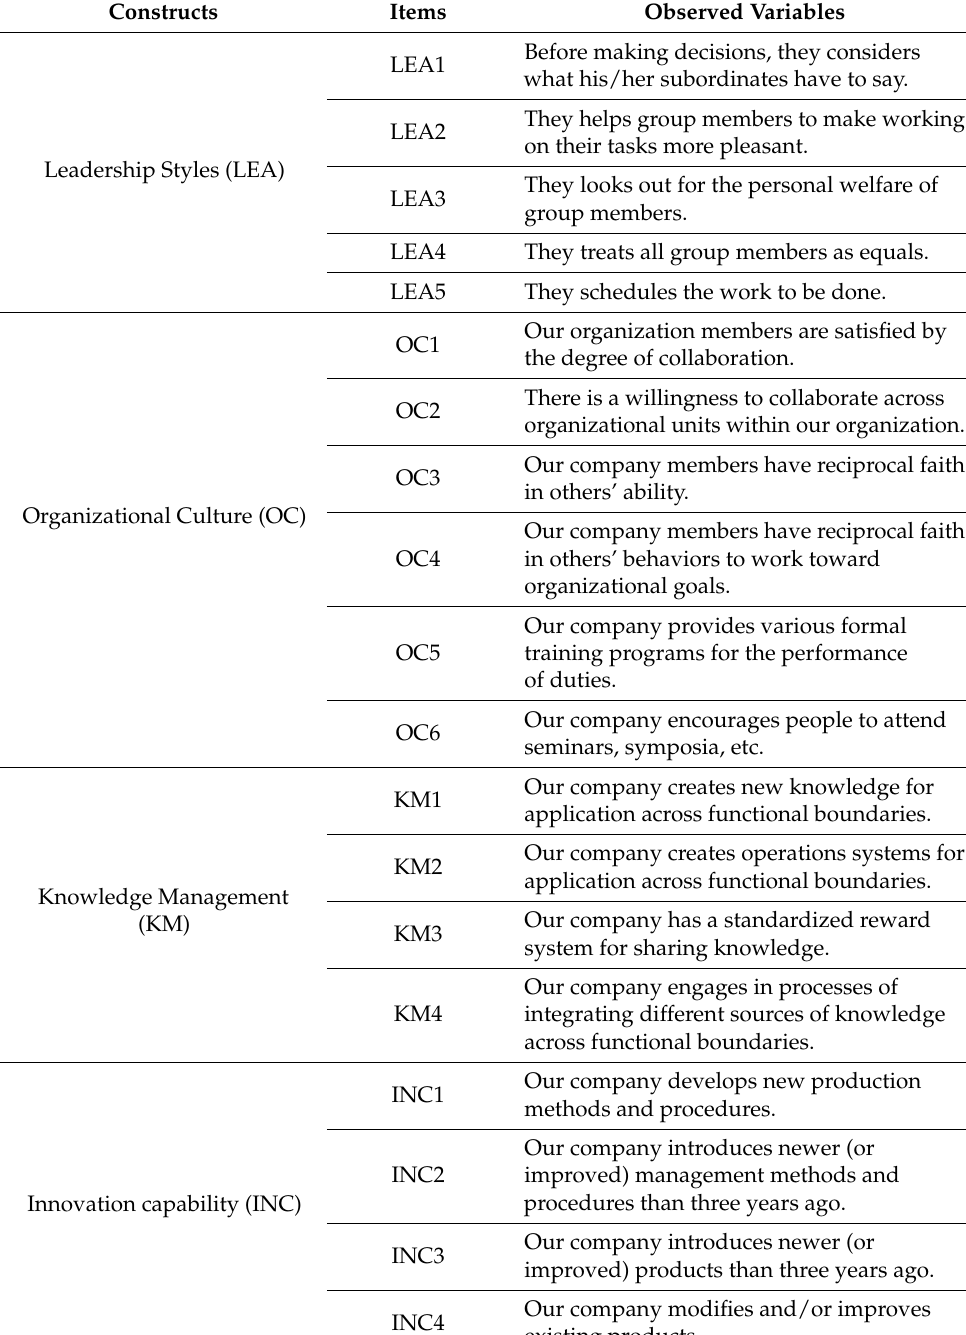
Table 2. Questionnaire constructs and